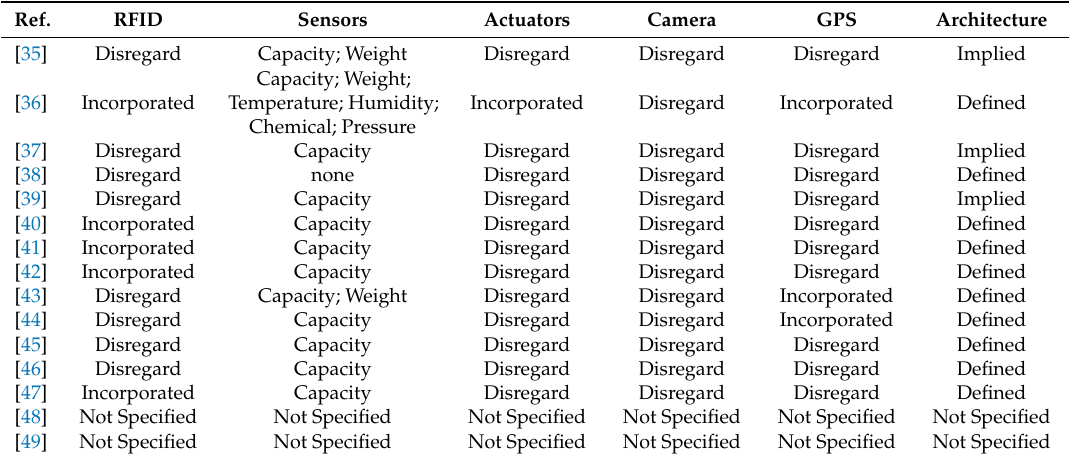
Table 2. IoT Technology comparison for the most relevant solutions available in the literature (Table 1). Ref.